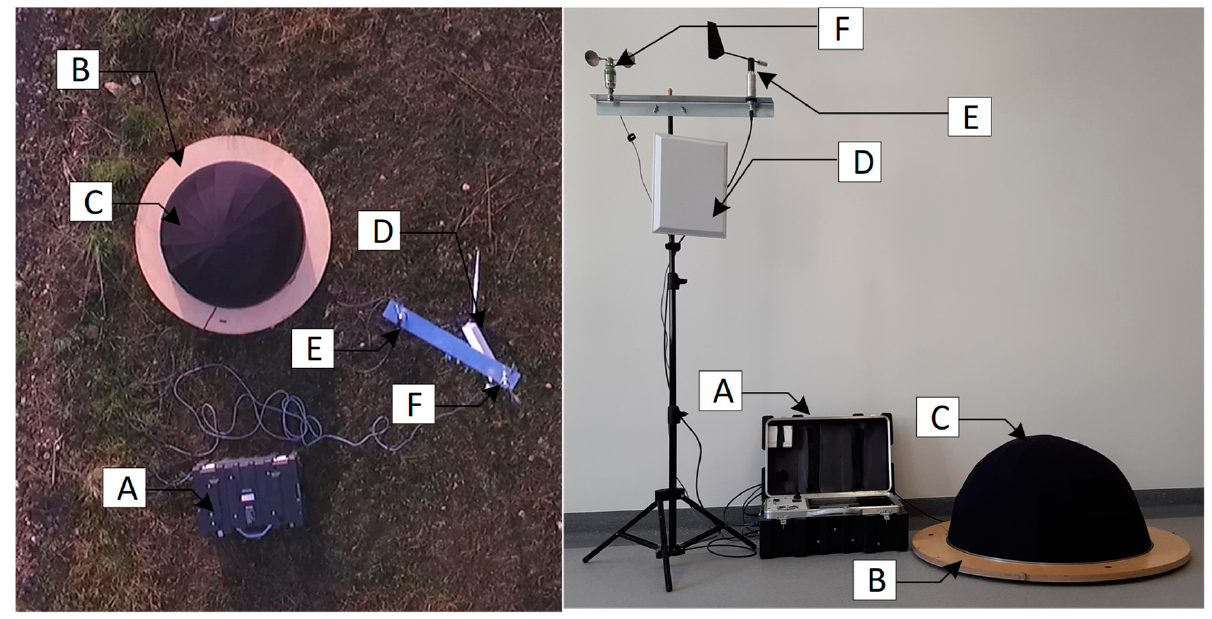
Figure 6. Photo of measuring station in the field (left) in the laboratory (right): A—measuring case, B—reflecting board, C—external wind protection, D—directional antenna LineEter 19, E—wind direction sensor, F—anemometer. Table 1. Summary of basic parameters of G.R.A.S. 46AZ microphone.